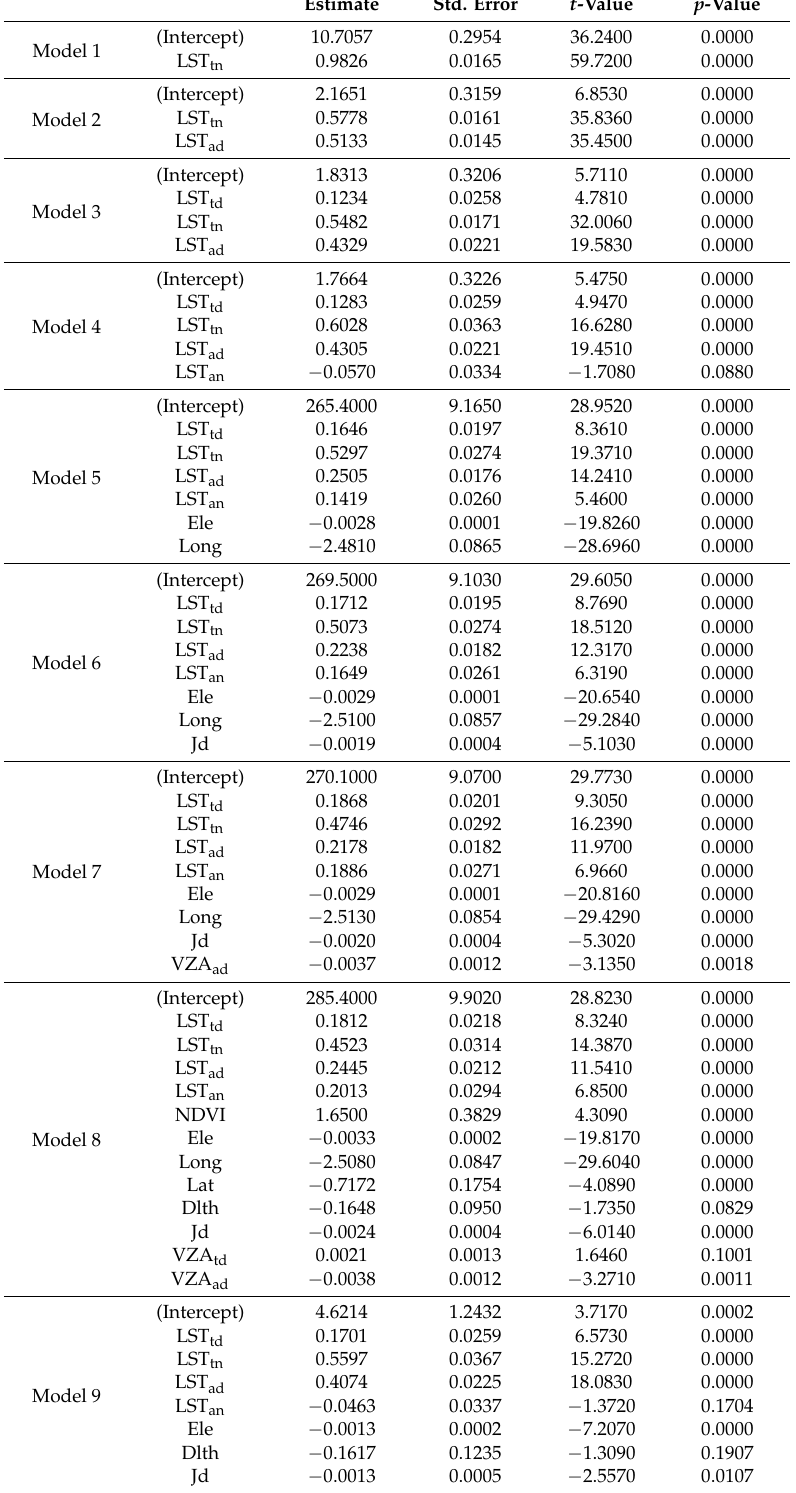
Table A1. Parameters of Models for T a-max